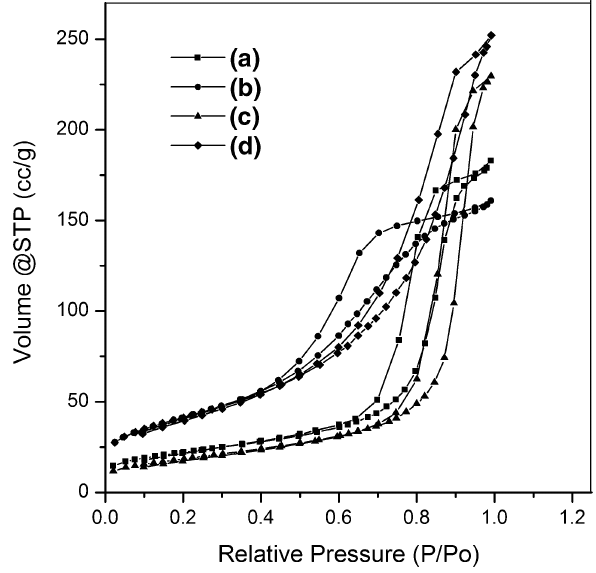
Fig. 7 Isotherm adsorption–desorption of zirconia prepared with and without sulfate and CTAB. a Z, b ZS, c MZ, and d MZS